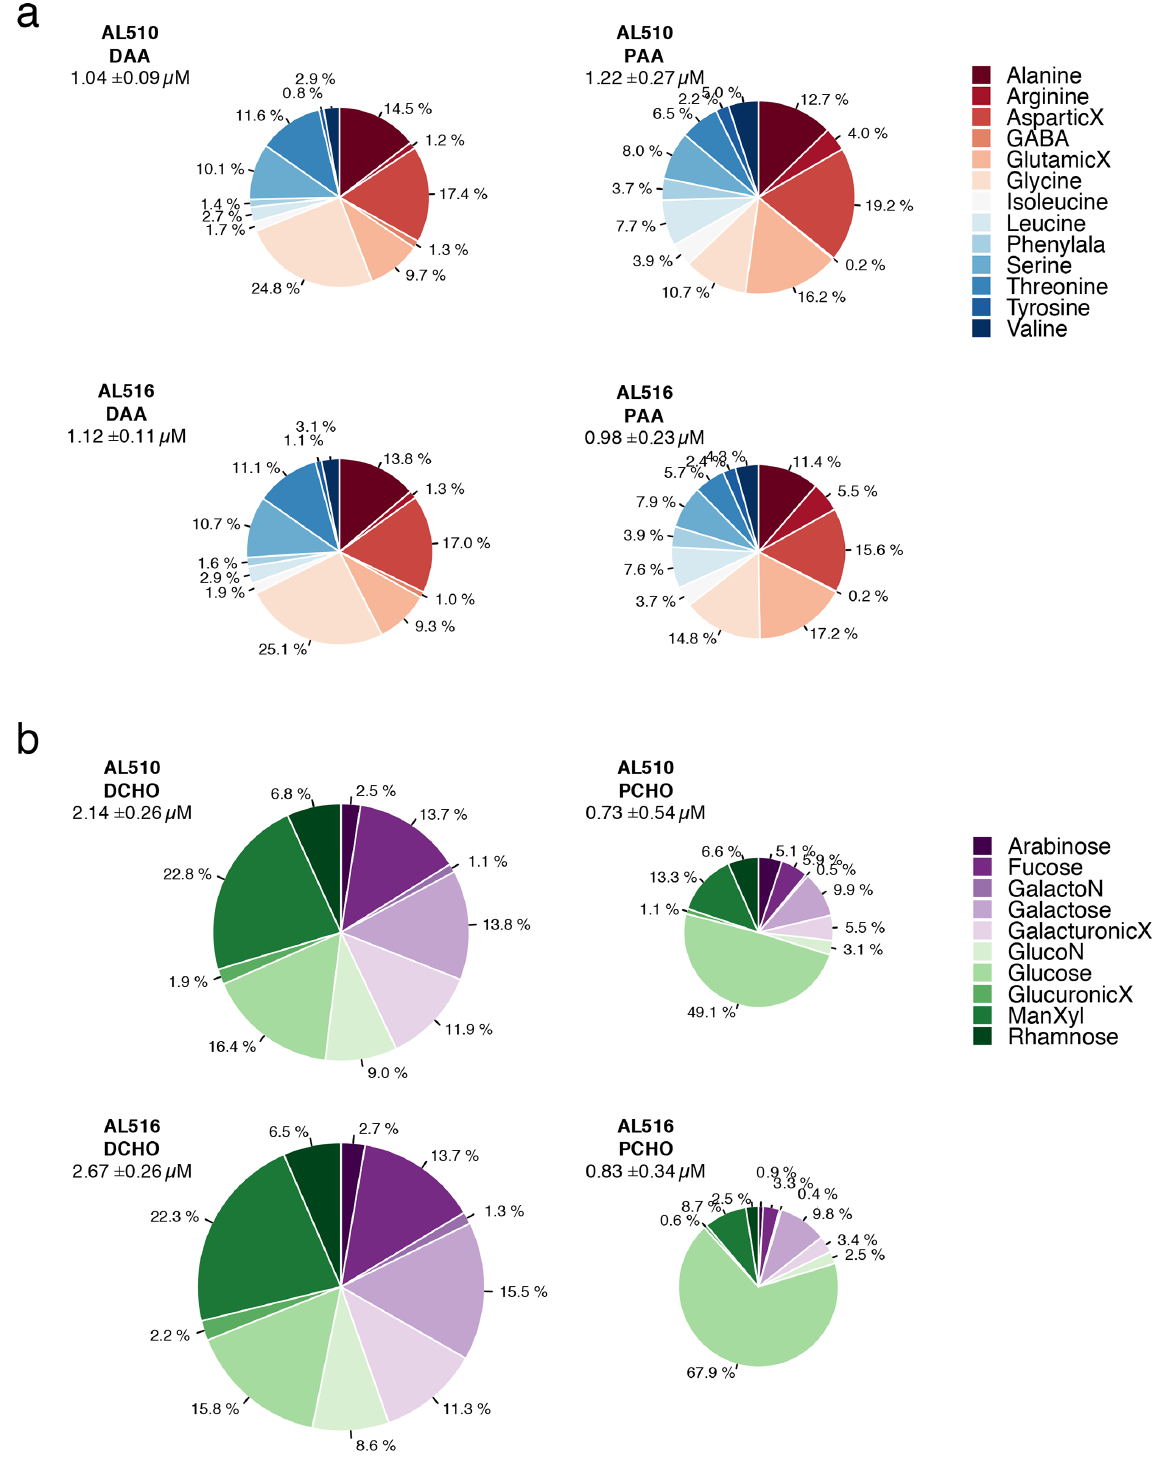
Figure 6. (a) Comparison of amino acid composition of the dissolved phase (DAA) and particulate phase (PAA) and seasons (AL510, June, and AL516, September) relative to total concentrations. (b) Comparison of carbohydrate composition of the dissolved phase (DCHO) and particulate phase (PCHO) and seasons (AL510, June, and AL516, September) relative to total concentrations. An uppercase “X” at the end of a term indicates acid; Phenylala denotes phenylalanine; GalactoN denotes galactosamine; GlucoN denotes glucosamine.